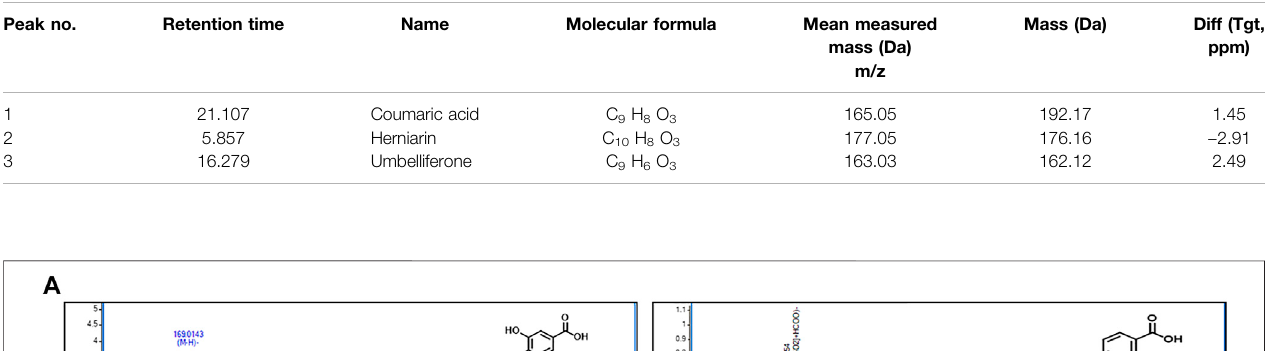
Frontiers in Pharmacology |